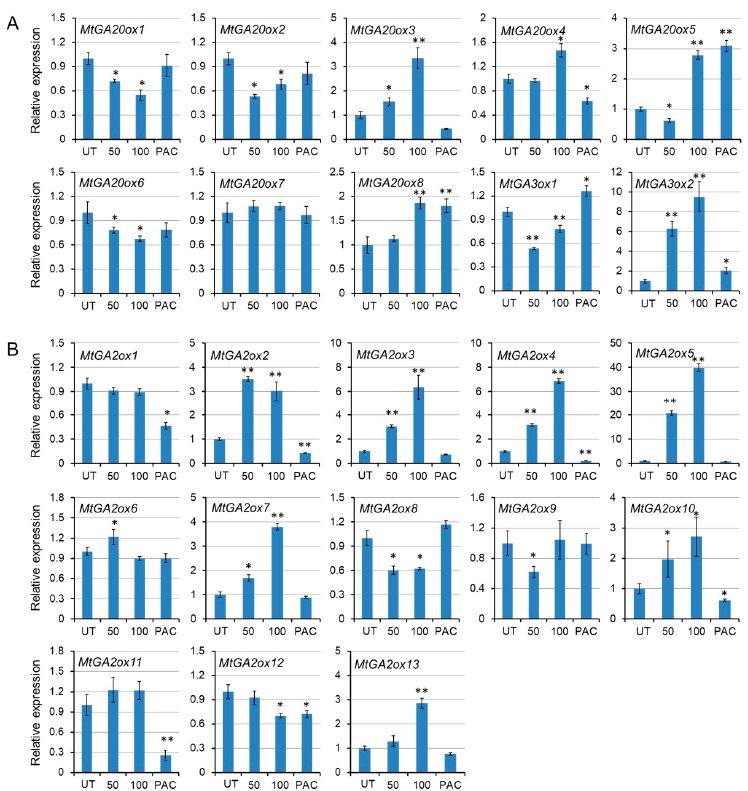
Figure 8. The transcript levels of MtGA20ox , MtGA3ox , and MtGA2ox are regulated by gibberellin 3 (GA 3 ) and its inhibitor paclobutrazol (PAC) through a feedback mechanism. ( A ) The transcript levels of MtGA20ox and MtGA3ox are regulated by GA 3 and PAC. ( B ) The transcript levels of MtGA2ox are regulated by GA 3 and PAC. Leaves are treated with 50 and 100 μ M GA 3 , and 10 μ M PAC. Gene expression is normalized to the control untreated (UT) expression level. Data represent the average of three independent experiments ± SD. * p < 0.05, ** p <